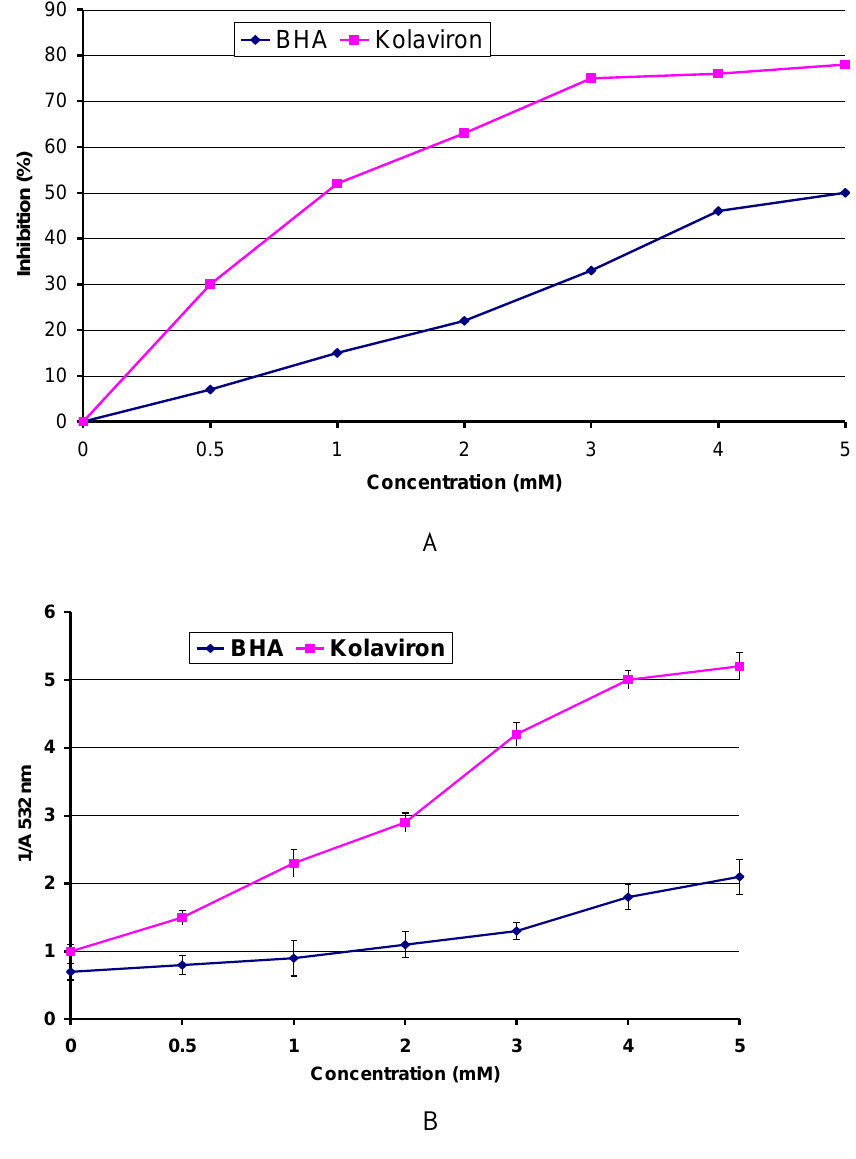
Figure 7. (A) Inhibition of deoxyribose oxidation by kolaviron and BHA. (B) A plot of Reciprocal Absorbance of TBARS at 532 nm against concentration of kolaviron and BHA for the Calculation of the rate constants. Values are means SD for three Experiments. (Adapted from Farombi et al.